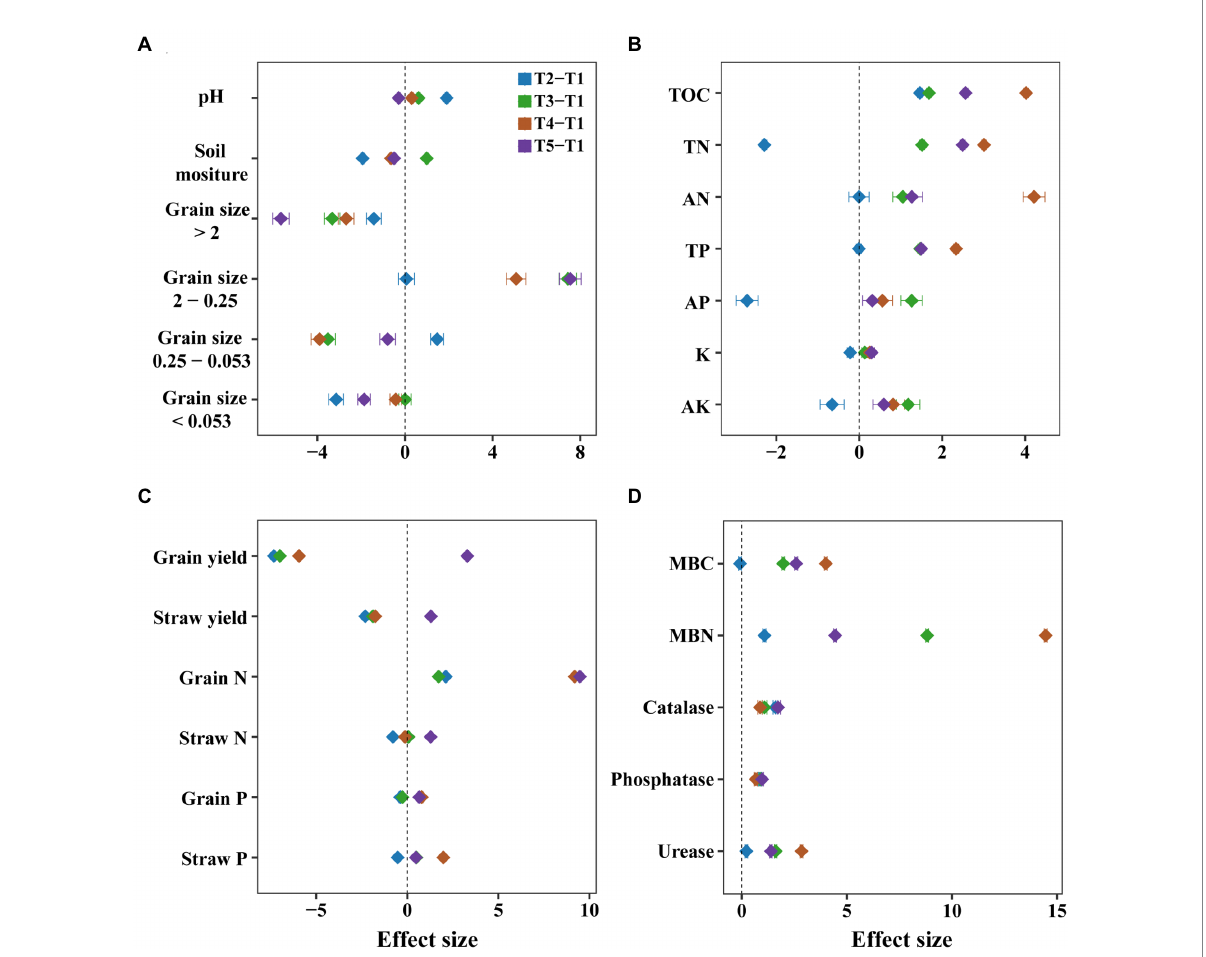
FIGURE 2 Comparison of the effects of monocropping and intercropping on soil physicochemical properties and ecosystem functions. We considered soil physicochemical properties (A) , soil nutrients (B) , crop nutrients (C) and the microbial biomass carbon (MBC) and nitrogen (MBN) and enzymes activities of urease, phosphatase, and catalase (D) . These soil physicochemical properties included soil moisture, pH, the grain sizes of aggregate <0.053, 0.25–0.053, 2–0.025, and >2 mm; soil nutrients included total organic carbon (TOC), total nitrogen (TN), total phosphorus (TP), total potassium (TK), available nitrogen (AN), available phosphorus (AP), available potassium (AK); crop nutrients included straw yield, grain yield, straw nitrogen (Straw N), straw phosphorus (Straw P), grain nitrogen (Grain N) and grain phosphorus (Grain P). The Cohen’s d is used as the effect size in our meta-analysis, and error bars denote the 95% confidence interval. T1, maize monocropping; T2, maize/sesame intercropping; T3, maize/ peanut intercropping; T2, maize/soybean intercropping; T2, maize/sweet potato